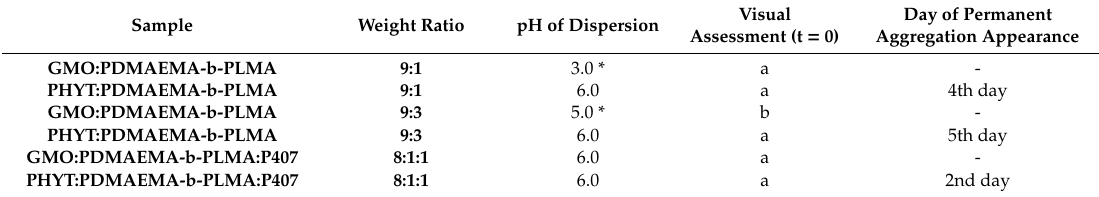
Sample Weight ratio